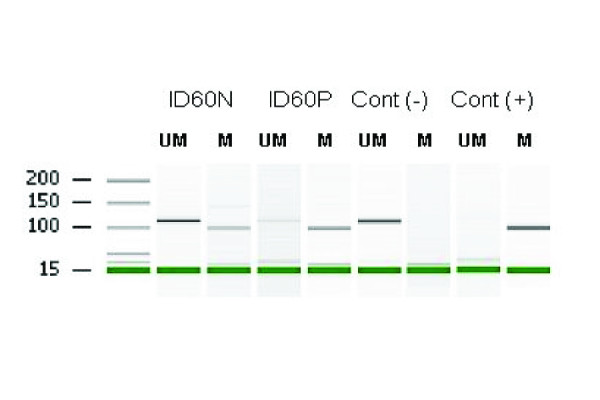
Lab-on-chip results of a MLH1 MSP performed on normal tissue and peripheral blood from patient ID60. Lane one contains the lab-on-chip DNA marker. Partial methylation of both normal colon mucosa (ID60N) and peripheral blood (ID60P) was observed as they show products produced by the primer pairs amplifying unmethylated (UM) and methylated (M) template DNA. Negative (Neg) and Positive (Pos) controls represent unmethylated (Neg) and methylated (Pos) controls, respectively. The first lane is a visualization of the Agilent DNA 1000 Marker 15/1500 in base pairs (bp)